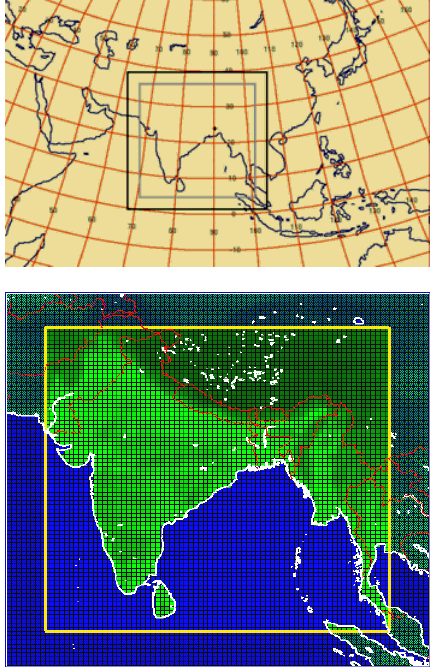
Figure 2. Schematization of PRECIS domain selection over